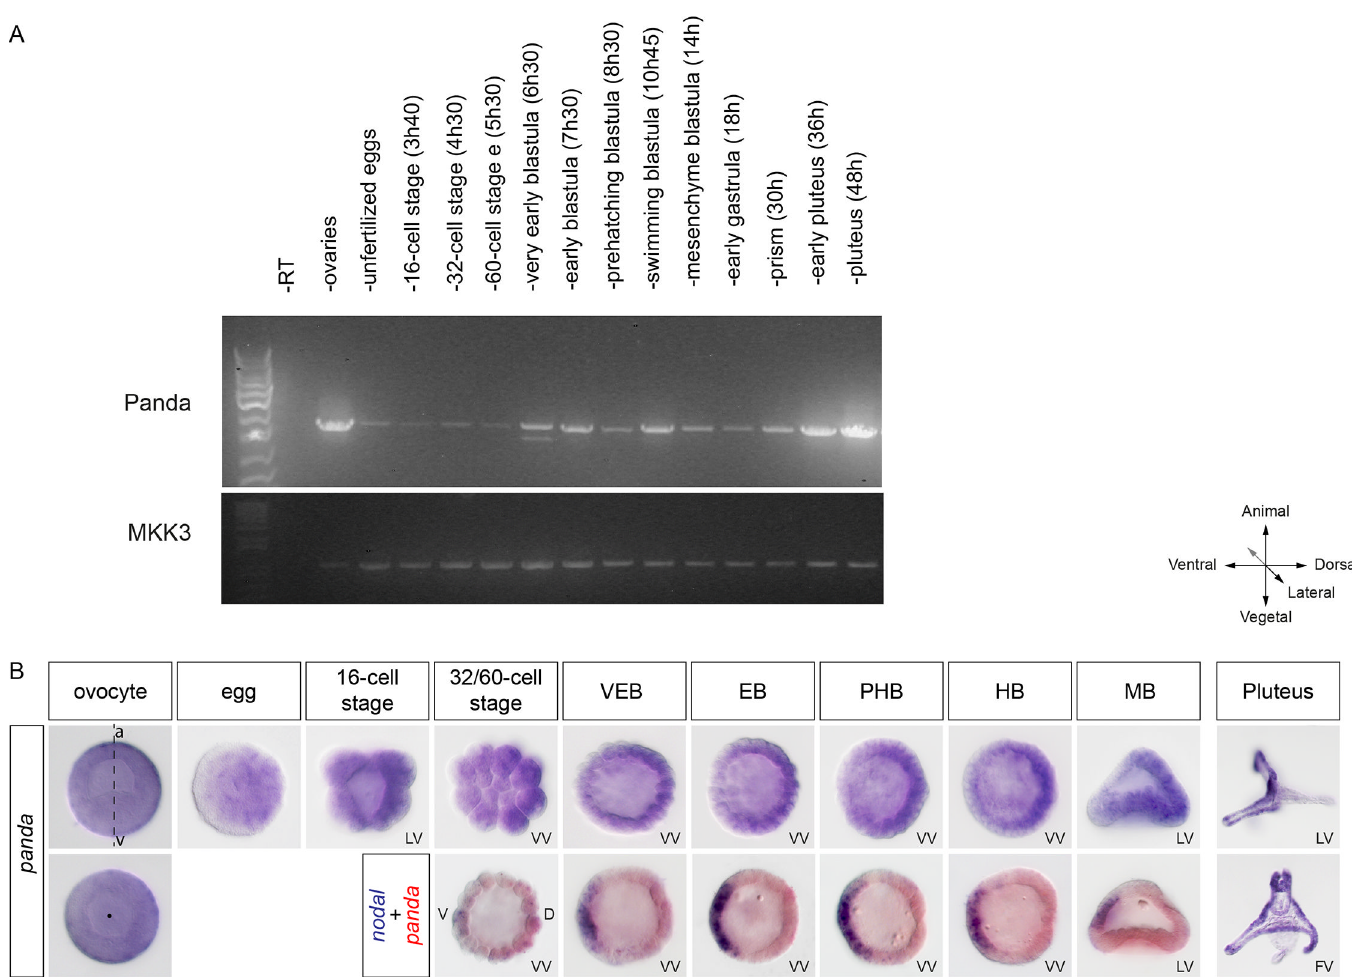
Fig 5. The TGF- β ligand Panda is expressed maternally in a D/V gradient. (A) RT-PCR analysis of Panda mRNA. An aliquot of the PCR reaction was run on a 1% agarose gel, and the gel was stained with Syber safe. Top panel, panda expression. Bottom panel, expression of mkk3 used as a control. Panda is expressed in ovaries and unfertilized eggs as well as during the cleavage, blastula, gastrula, and pluteus stages. (B) Expression of panda mRNA analyzed by in situ hybridization. Whole mount in situ hybridizations with panda alone or with panda (red) and nodal (blue) probes. A gradient of maternal panda mRNA is detected in immature ovocytes and to a lesser extent in the unfertilized mature eggs, whereas during the cleavage and blastula stages, panda mRNA is detected in a shallow D/V gradient. VEB, very early blastula (about 120 cells); EB, early blastula (about 220 cells); PHB, prehatching blastula (about 300 cells); HB, hatching blastula (about 400 cells); MB, mesenchyme blastula; LV, lateral view; VV, vegetal view; V, ventral; D, dorsal; FV, frontal